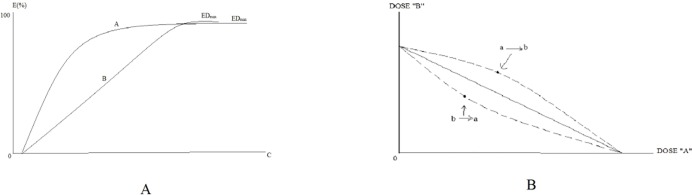
Examples of rectangular hyperbolic dose-effect curves. (A) is the example of rectangular hyperbolic dose-effect curves. (B) is the isobologram of the interaction between two drugs.